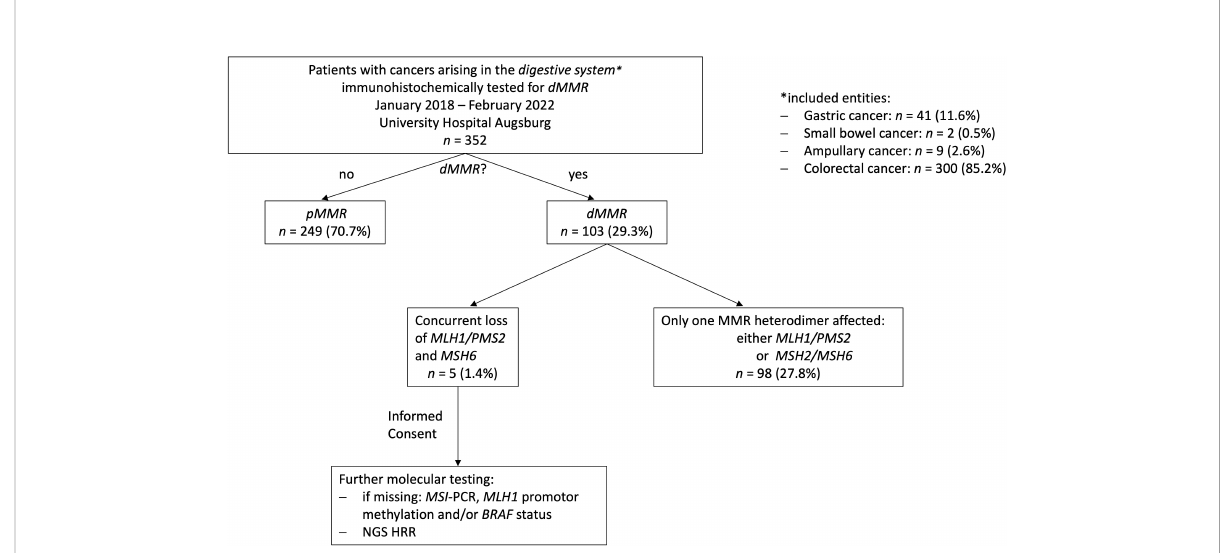
FIGURE 1 Study fl ow chart. 352 digestive system cancer samples underwent immunohistochemical testing for MMR de fi ciencies over a 4-year period at our hospital (University Hospital Augsburg, Germany). Only, fi ve MLH1 - /PMS2 - /MSH6 - could be identi fi ed. Consecutively, additional extensive molecular testing including a NGS panel focusing on genes involved in MMR/HRR was applied on these